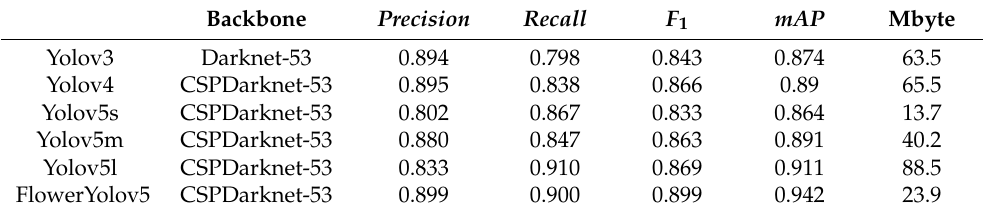
Table 1. Comparison results of the different models for tomato flowers.